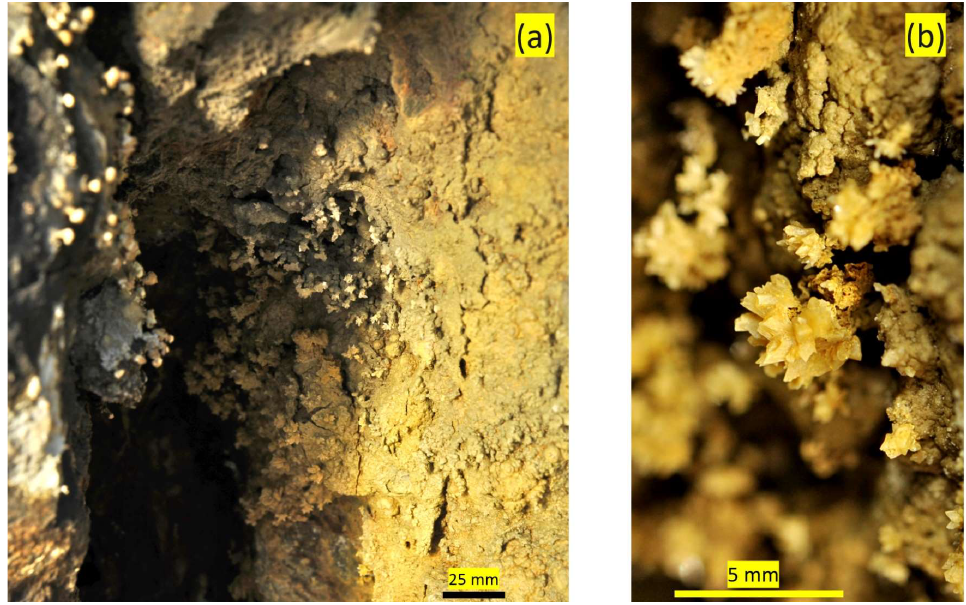
Figure 21. Image of gypsum formation in a sheltered part of a hole-like structure ( a ) in the rock at Stefføya. The image to the right ( b ) is a closer view of the gypsum formed on top of the jarosite. There is a contrast between the inner part of hole and the outer part. The gypsum formed on the top